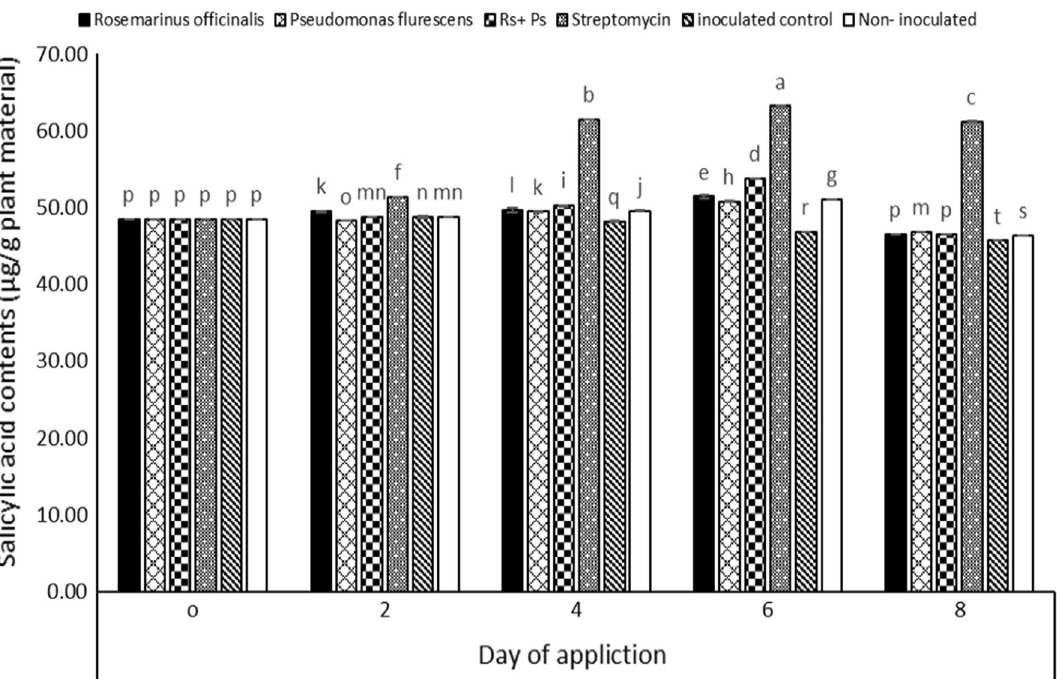
Fig. 2 Effect of Rosemarinus officinalis and Pseudomonas fluorescans on salicylic acid contents in inoculated potato plants. Values followed by different letters indicate that means are significantly different, while identical letters indicate that means are not significantly different according to Fisher’s least significant difference at p =